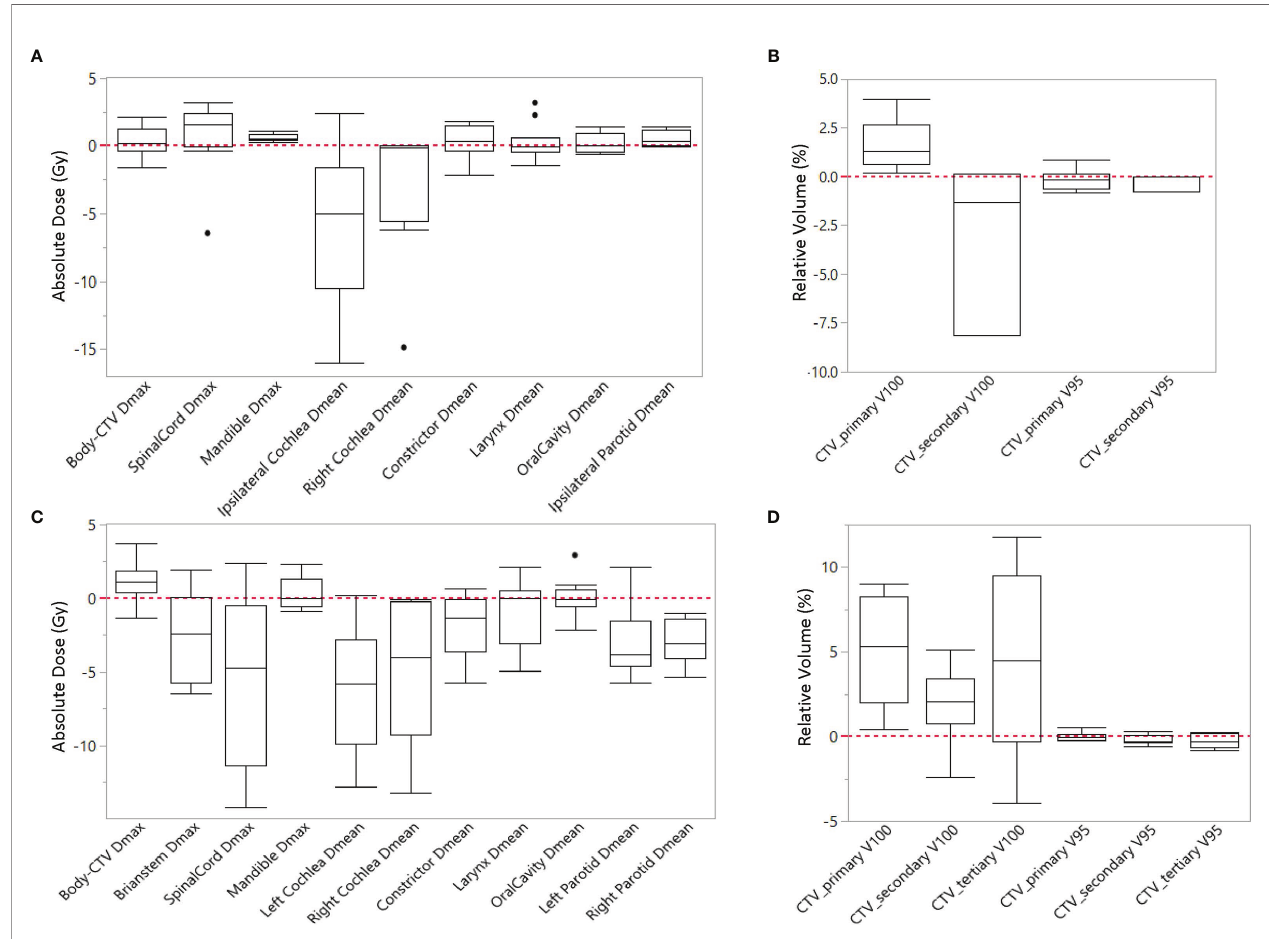
FIGURE 2 | Difference of averaged dose-volume indices over all scenarios between RPP plans and expert plans for (A, B) unilateral cases, and (C, D) bilateral